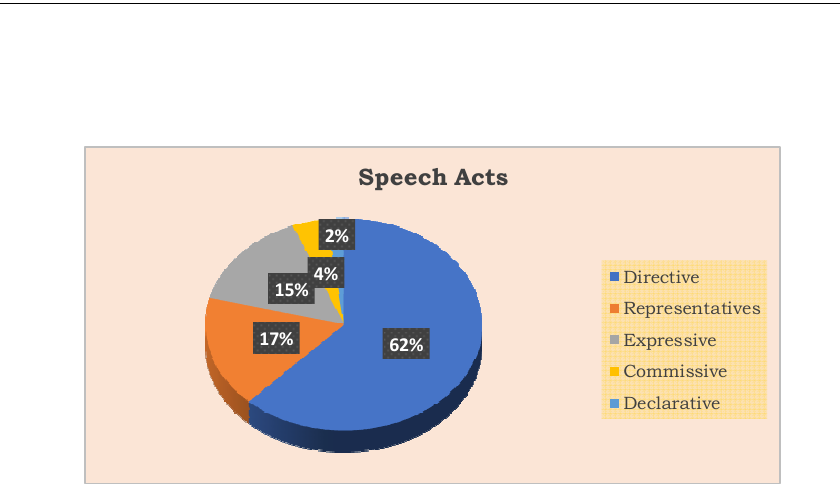
Figure 1. Speech acts occurring in the English pedagogical